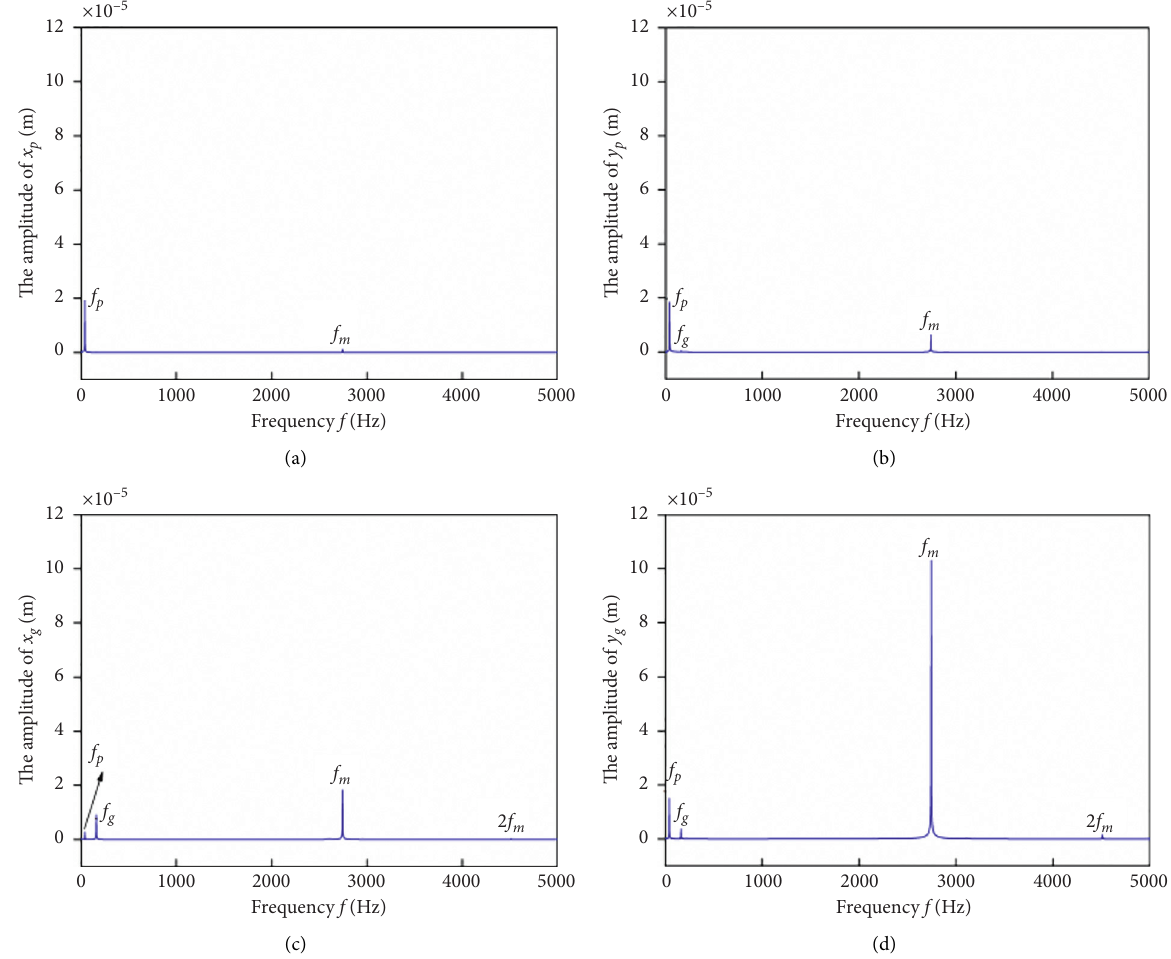
Figure 17: The frequency-domain responses at i � 4. (a) The driving gear in x direction. (b) The driving gear in y direction. (c) The driven gear in x direction. (d) The driven gear in y